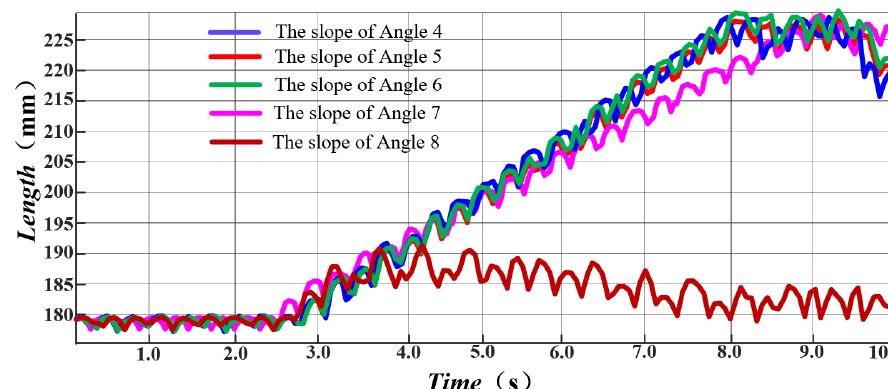
Figure 14. Displacement of the centroid along the y direction during climbing.